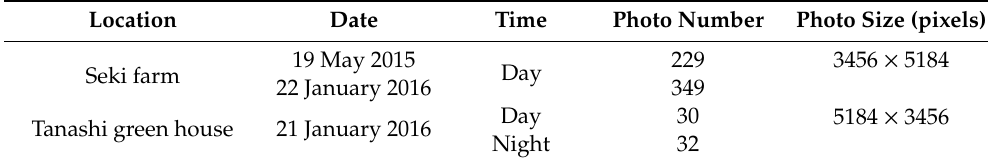
Table 1. Details of the dataset.